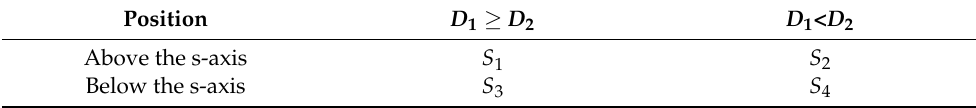
Table 1. Pedestrian location statistics for behavioral decision making (1).